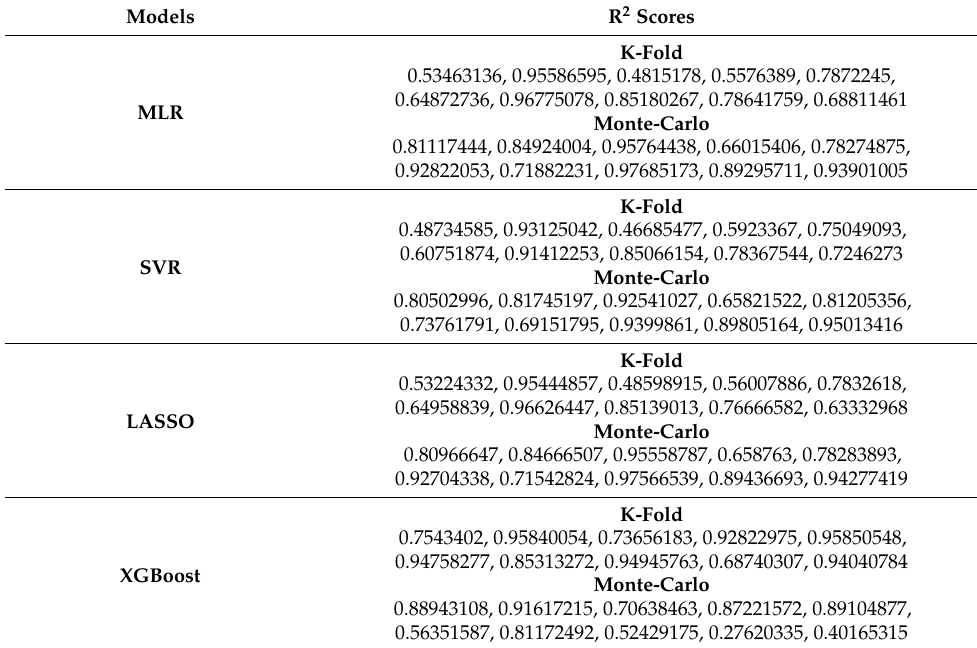
Table 4. Generated 10 folds validation values for K-Fold and Monte-Carlo in Python.